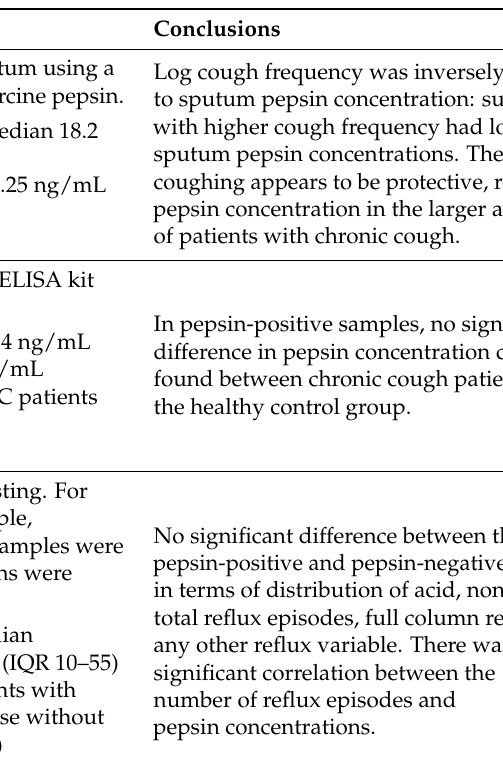
Table 3. Summary of the studies investigating pepsin levels in biological fluids retrieved from adult and paediatric subjects and the relationship between pepsin